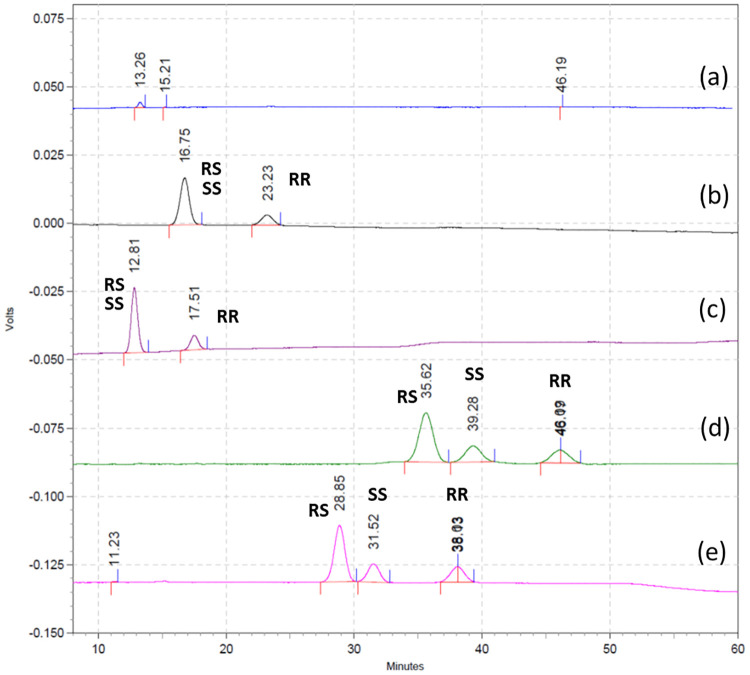
Chiral HPLC chromatograms.Using Chirex 3126 column: 150 mm × 4.6 mm. a) MeOH:2 mM CuSO4 = 15:85 at 27°C; b) IPA:2 mM CuSO4 = 15:85 at 25°C; c) IPA:2 mM CuSO4 = 15:85 at 35°C; d) MeCN:2 mM CuSO4 = 15:85 at 25°C; e) MeCN:2 mM CuSO4 = 15:85 at 35°C.